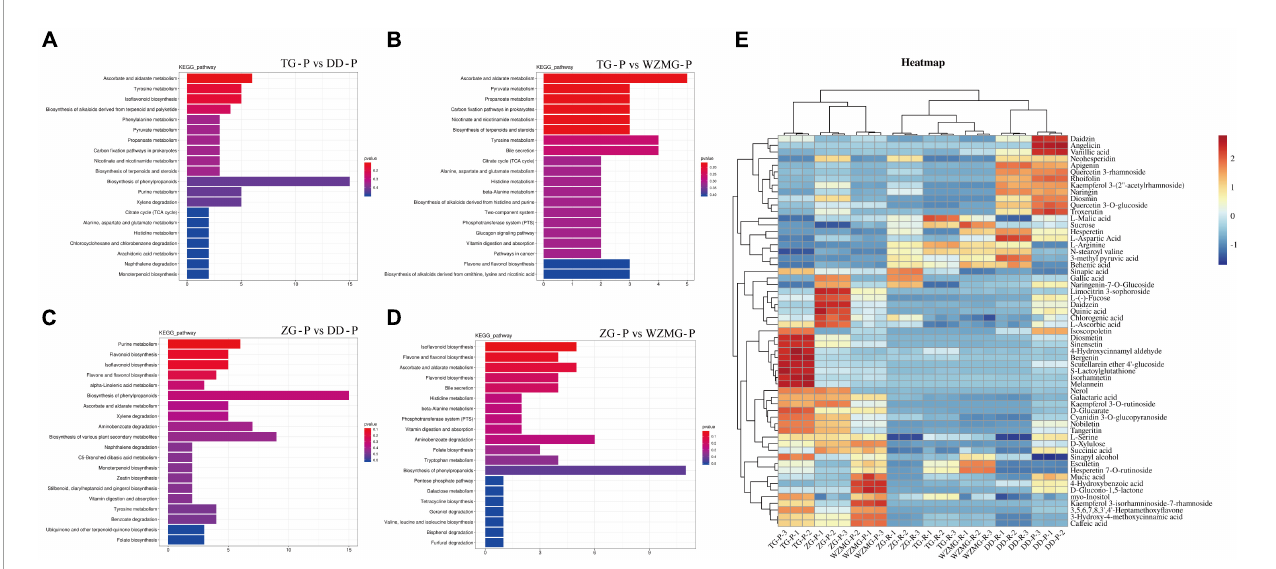
FIGURE4 Analysis of the DAMs and nutrition and antioxidant metabolites in ZG and TG. KEGG pathway enrichment analysis of DAMs in groups TG-P vs. DD-P (A) , TG-P vs. WZMG-P (B) , ZG-P vs. DD-P (C) , and ZG-P vs. WZMG-P (D) . (E) Heatmap of the key DAMs in the peel and pulp.